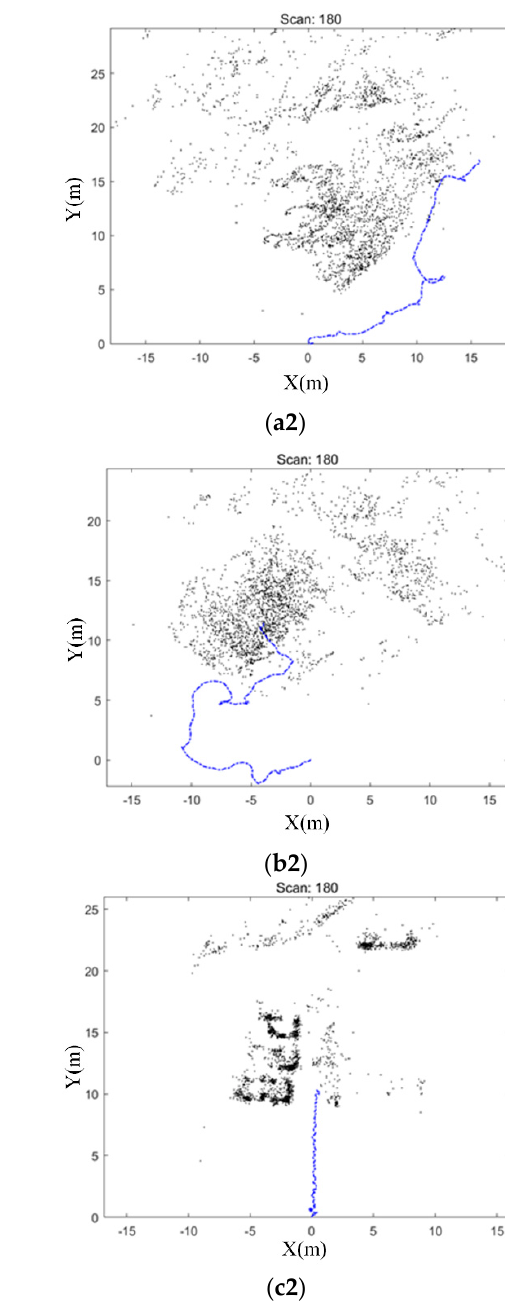
( c3 ) Figure 12. The three sets of pictures. ( a – c ) correspond to three scenes. ( a1 – c1 ) Partial image of the real scene; ( a2 – c2 ) Outlier recognition result when RCS feature is not used, red is outlier; ( a3 – c3 ) Outlier recognition result when RCS feature is used, red is outlier. 4.3. Trajectory and Map In this section, first, the three improved CSM methods combining RCS features proposed in Section 3.2 were analyzed and verified. In order to simply compare the pros and cons of the three methods, clustering was not performed here, and the aid of IMU and Odometry was not used. This paper compared the map and the trajectory respectively. When comparing maps, the true value of the radar track was required. Since the experiment had no true value, this paper used a group of best